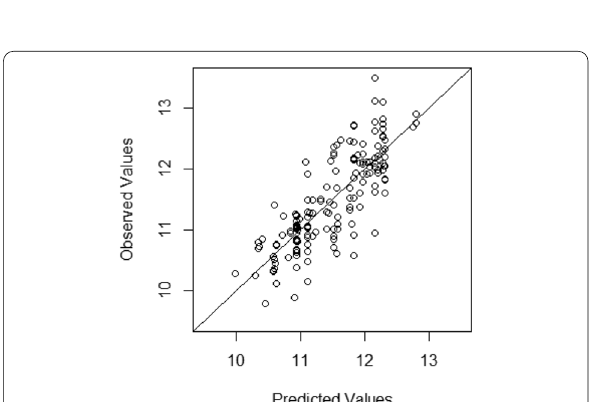
Fig. 6 Scatter plot of predicted and observed values of Analysis 2 (Martin). The unit of the axes is the logarithm of winning bid